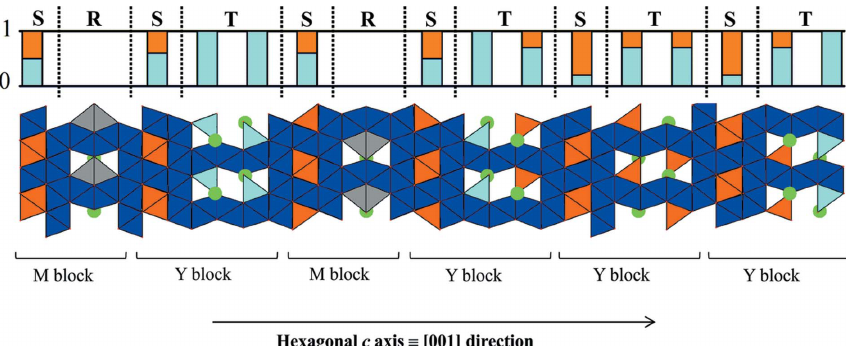
Figure 6 Partial projection of the (34) 3 hexaferrite structural model corresponding to the MYMY 3 sequence. The unit cell contains a threefold repeat of the sequence shown, with subsequent repeats translated in plane by (2/3, 1/3). The tetrahedral (light blue), octahedral (dark blue) and bipyramidal (grey) iron environments are represented. Tetrahedral mixed iron/zinc sites are shown in orange and barium atoms are shown in green. The histogram indicates the proportions of iron (light blue) and zinc (orange) occupancy in the tetrahedral sites.